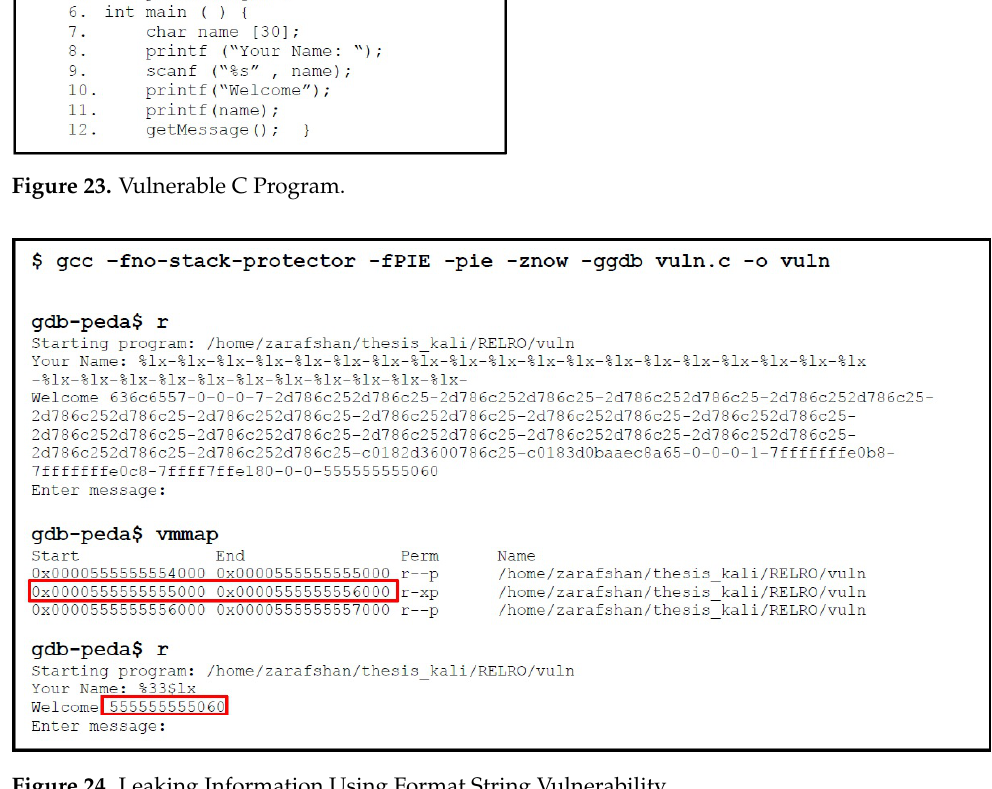
Figure 24. Leaking Information Using Format String Vulnerability.